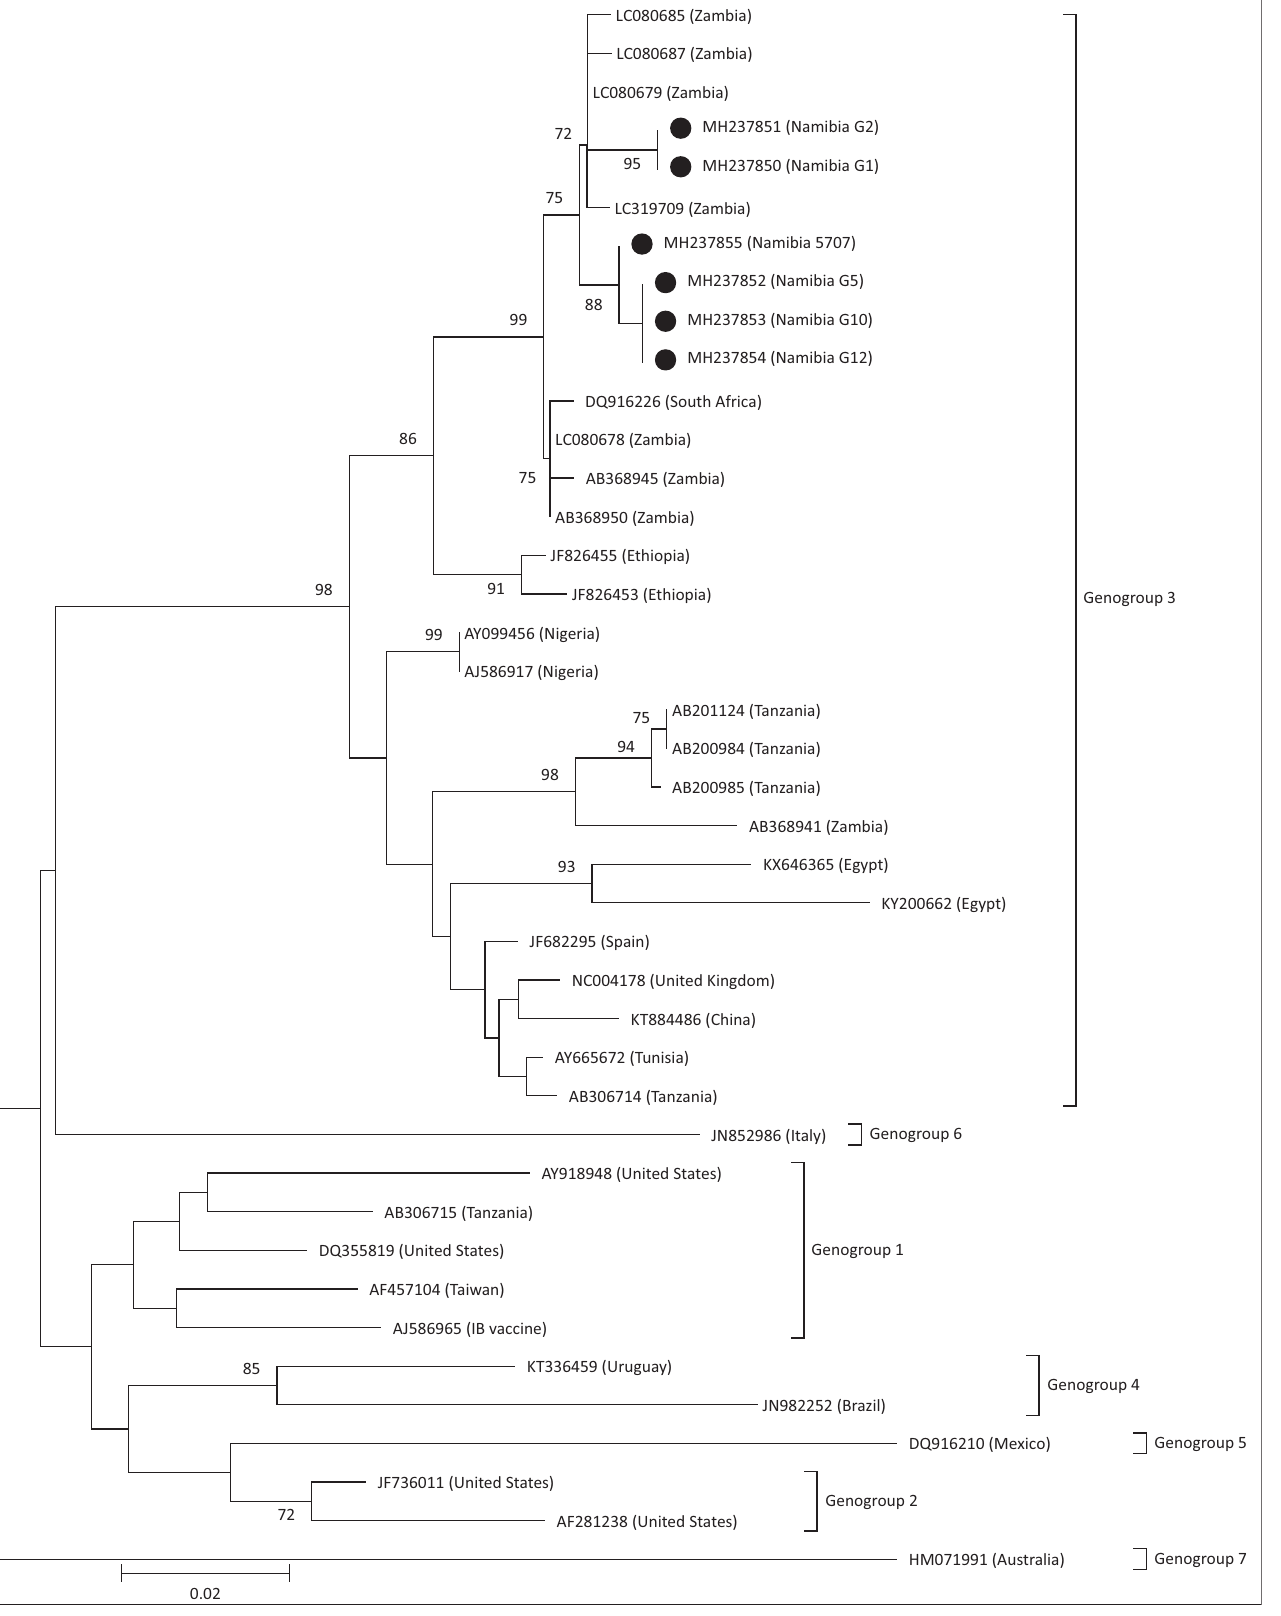
FIGURE 1: Neighbour-joining analysis using the MEGA6 software of a partial nucleotide sequence (403 bp) of the VP2 gene from the infectious bursal disease virus samples investigated (filled circles) and representative sequences from GenBank. The numbers indicate the bootstrap values calculated from 1000 bootstrap replicates. The scale bar represents nucleotide substitutions per site. The different Genogroups are indicated as described by Michel and Jackwood